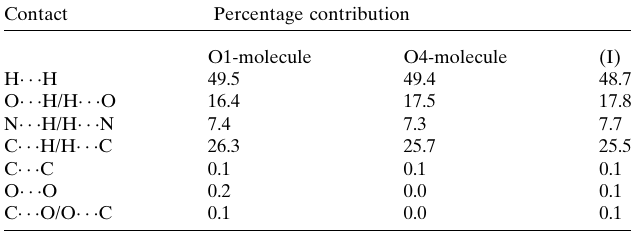
Table 3 Percentage contributions of interatomic contacts to the Hirshfeld surface for the O1-molecule, the O4-molecule and for overall (I).